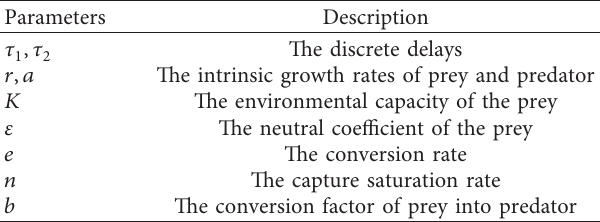
Table 1: Biological meanings of parameters for model